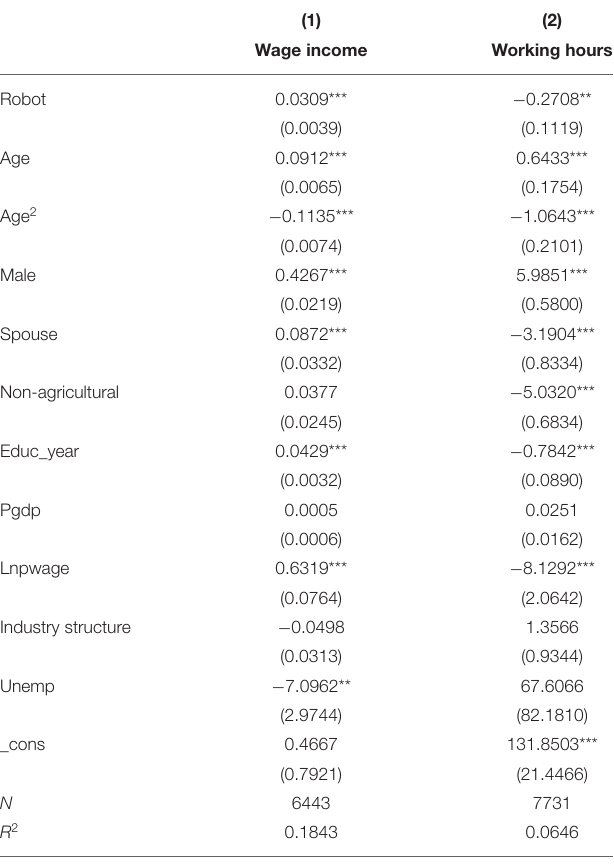
TABLE 7 | Mechanism